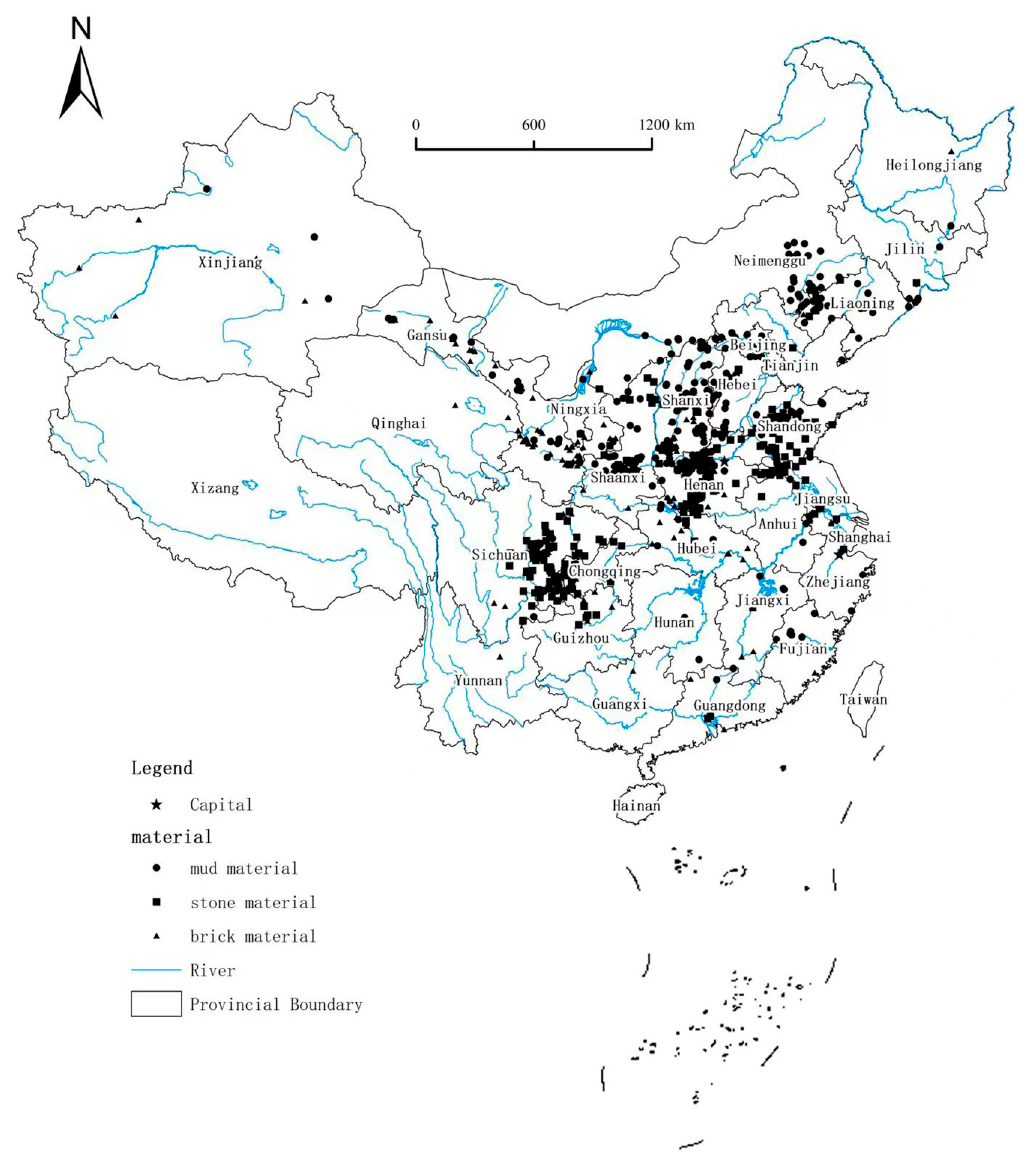
Figure 2. Distribution map of the types of Chinese tomb mural relics.